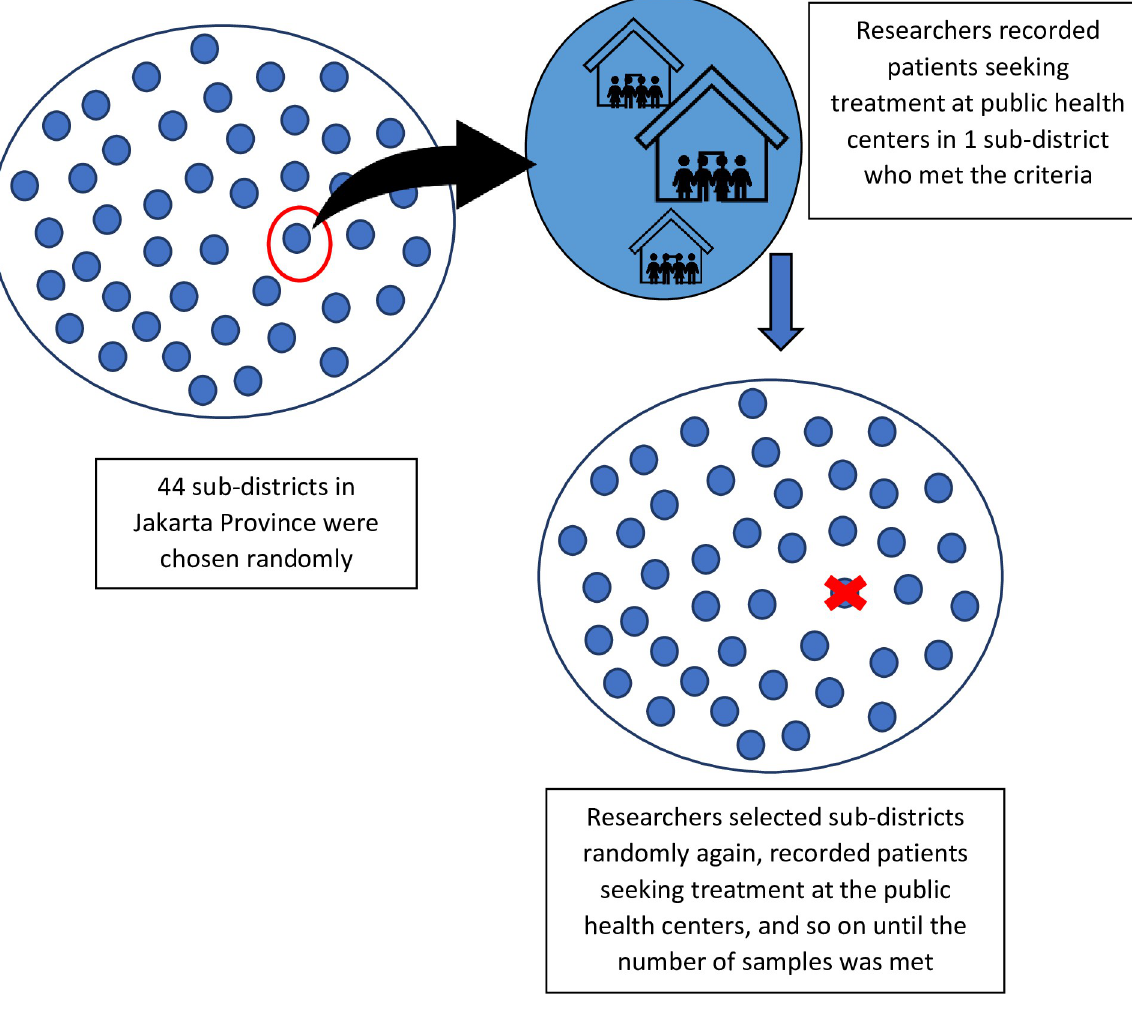
Fig 4. Cluster random sampling based on